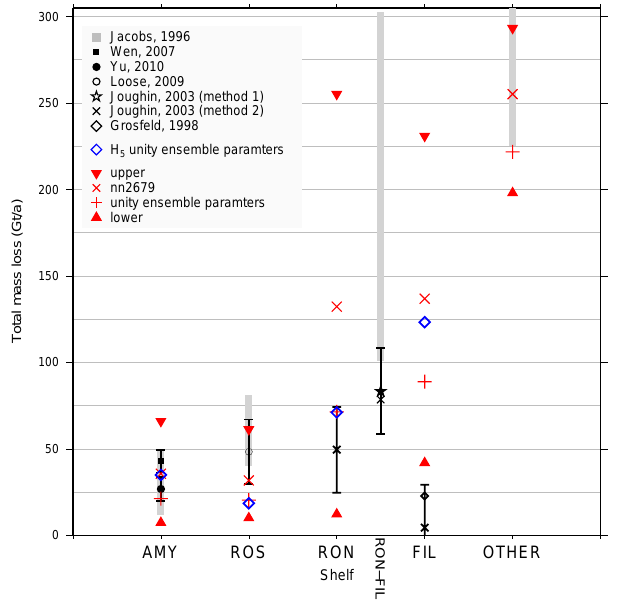
Fig. 6. Comparison plot showing net melt amounts from observa- tions and the predicted melt amount from the SSM component for each of the five shelf regions; two observations that are for the cu- mulative RON-FIL are also shown. The OTHER observation has been clipped as the maximum, estimated from Jacobs et al. (1996), peaks at 675Gt yr − 1 (see Supplement Table 4).